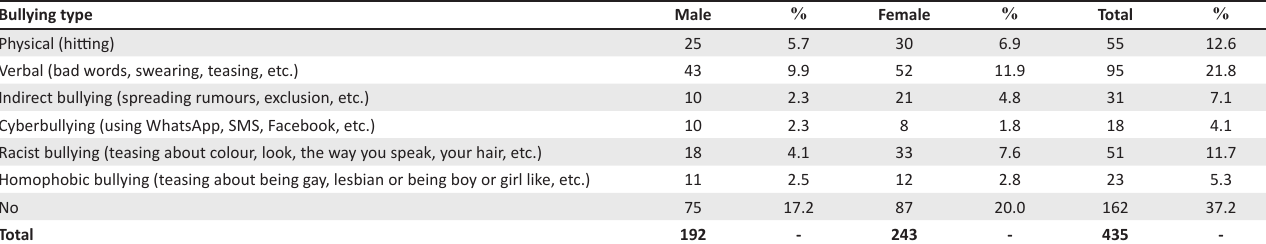
TABLE 3: Prevalence according to types of bullying. Bullying type Verbal (bad words, swearing, teasing, etc.) Indirect bullying (spreading rumours, exclusion, etc.)